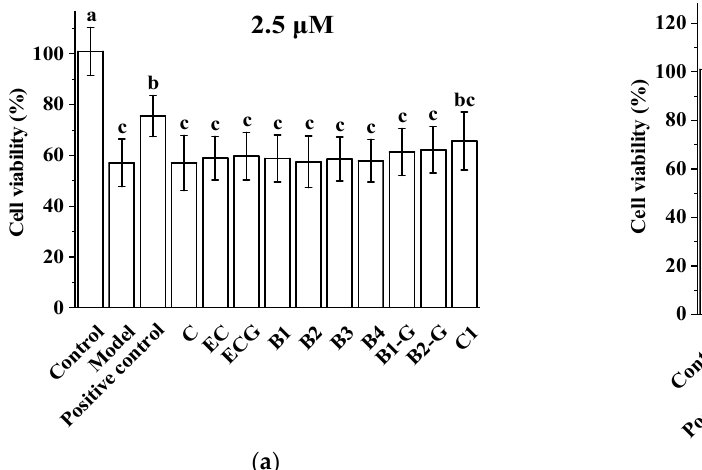
effect on H 2 O 2 -induced PC12 cell injury (Figure 2a, p > 0.05), whereas 5 µ M procyanidins (B1, B2, B3, B4, B1-G, B2-G, and C1) had significant protective effects on PC12 cell injury induced by H 2 O 2 (Figure 2b, p < 0.05).